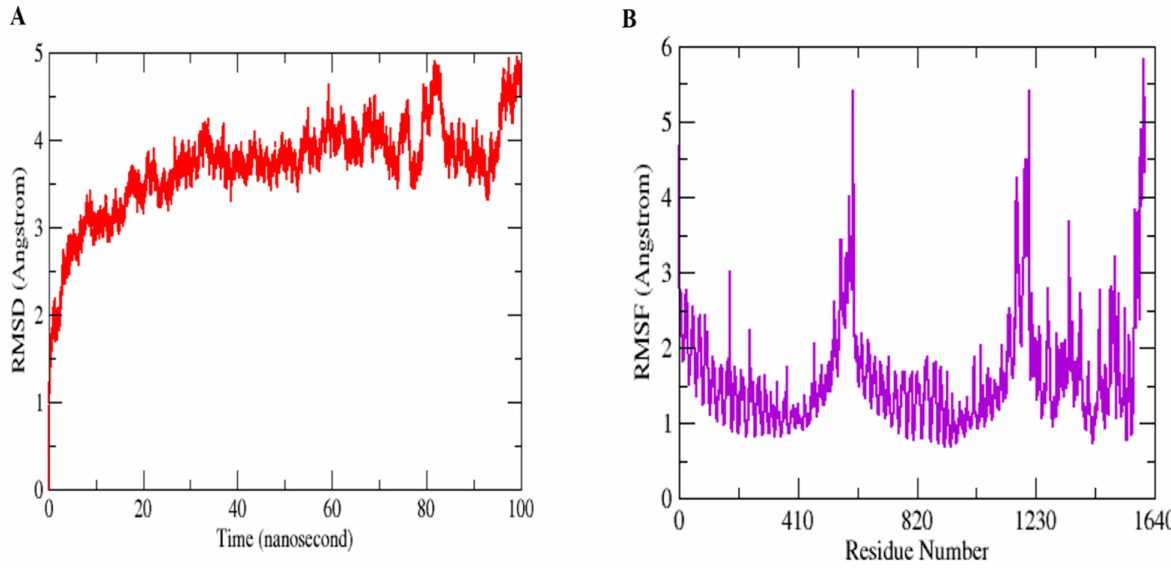
Figure 8. MD simulation paths are statistically analyzed. RMSD ( A ) and RMSF ( B ) are the two output values shown